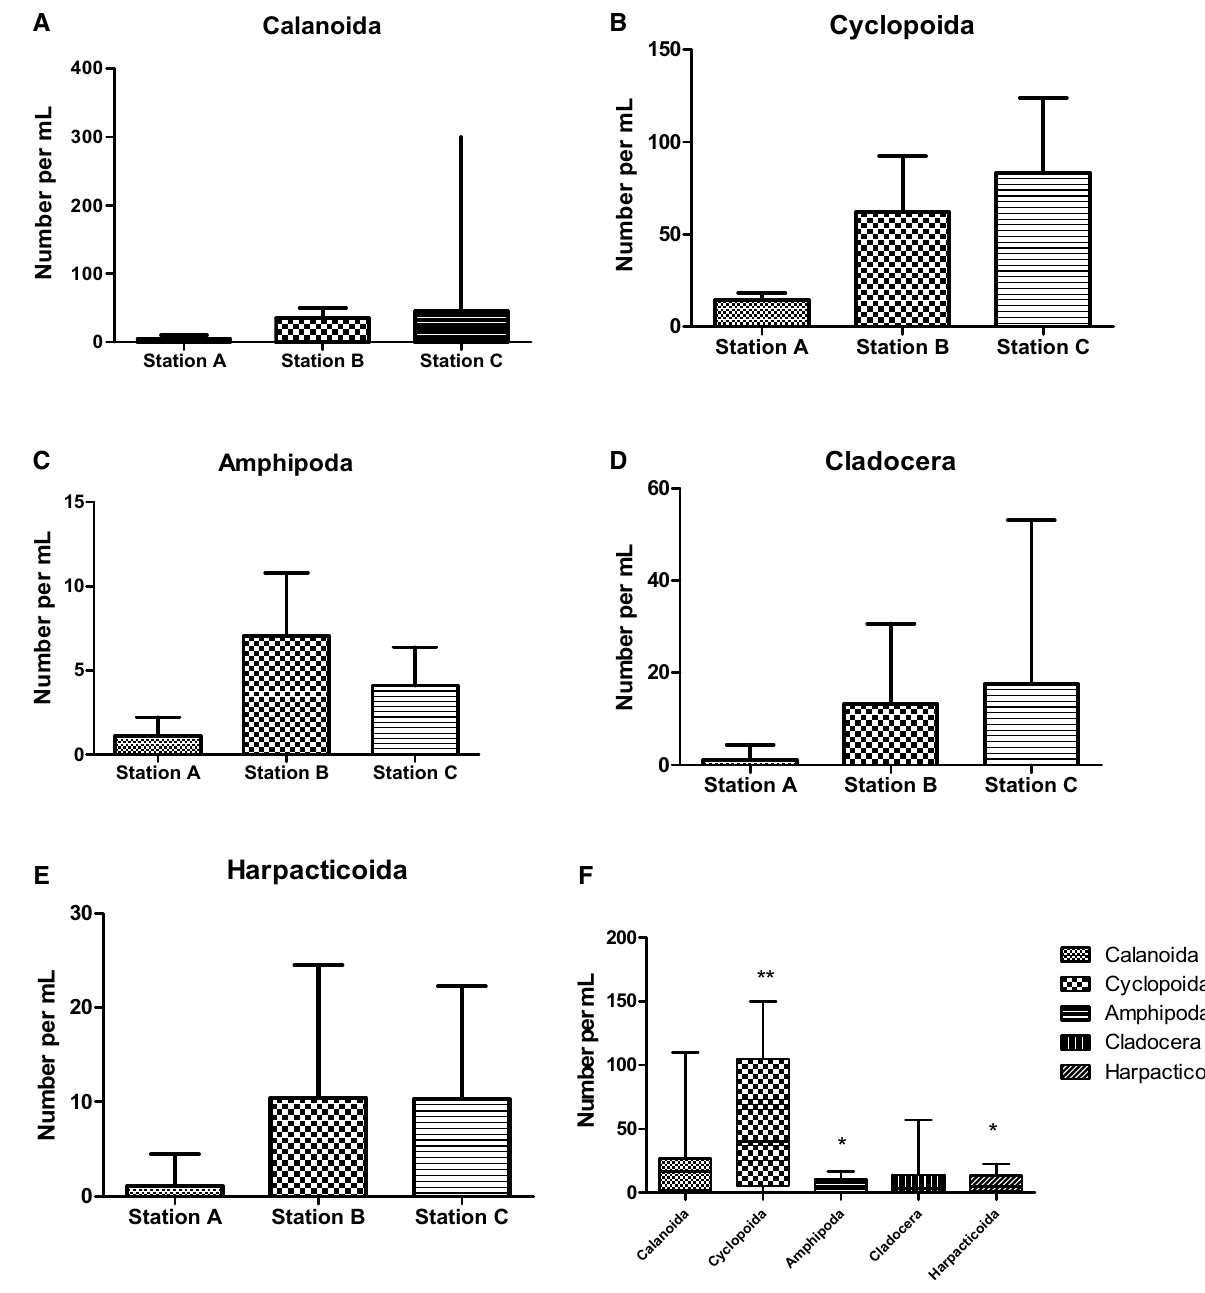
Figure 2. Comparative variation of zooplankton taxa. A = spatial variation of Calanoida. B = spatial variation of Cyclopoida. C = spatial variation of Amphipoda. D = Spatial variation of Cladocera. E = Spatial variation of Harpacticoida. F = Comparative abundance among zooplankton taxa of Egbokodo River. ** is significantly higher than * (p < 0.05). Sample size (N) of A–E = 6, F =